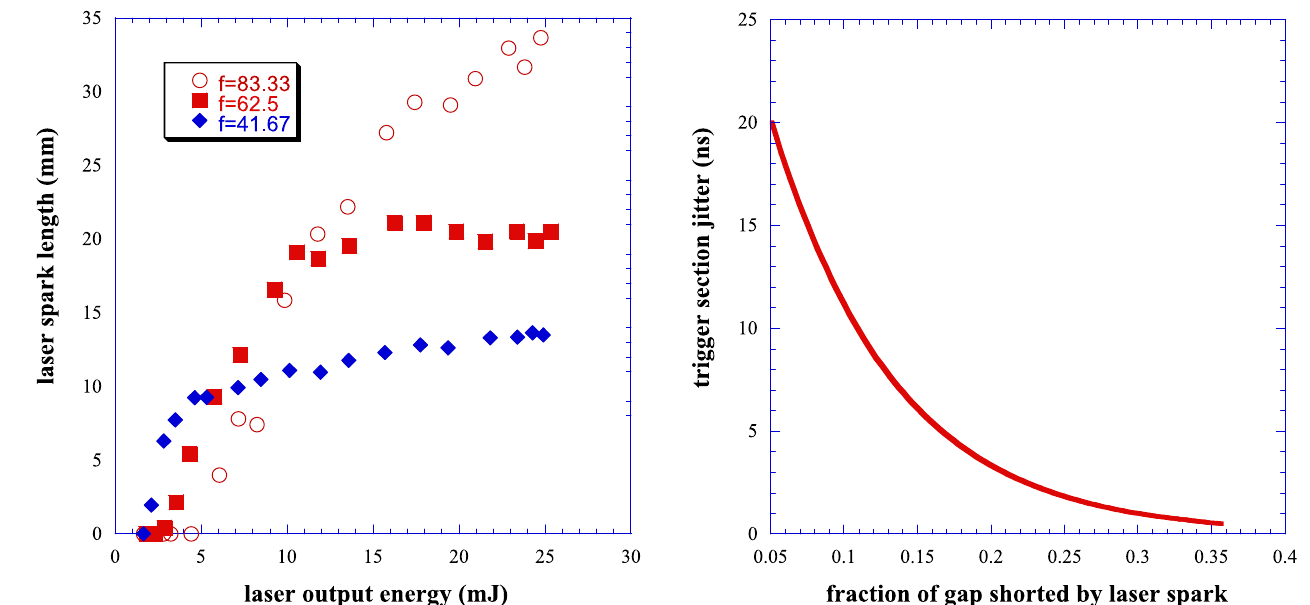
FIG. 15. (Color) Laser energy versus visible spark length for three f -numbers.